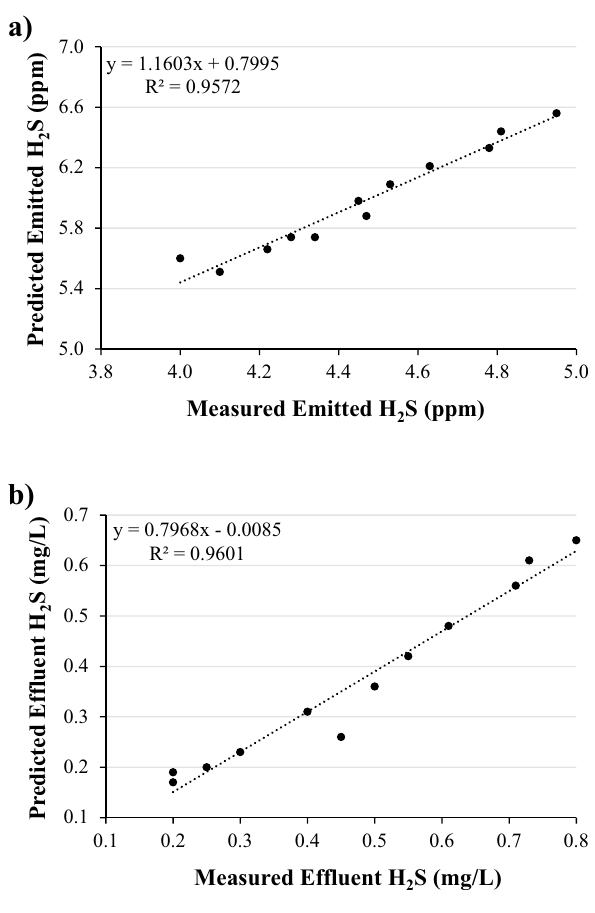
Figure 2. The comparison of measured (x-axis) and predicted (y-axis) H 2 S: ( a ) emitted to atmosphere and ( b ) discharged with effluent.